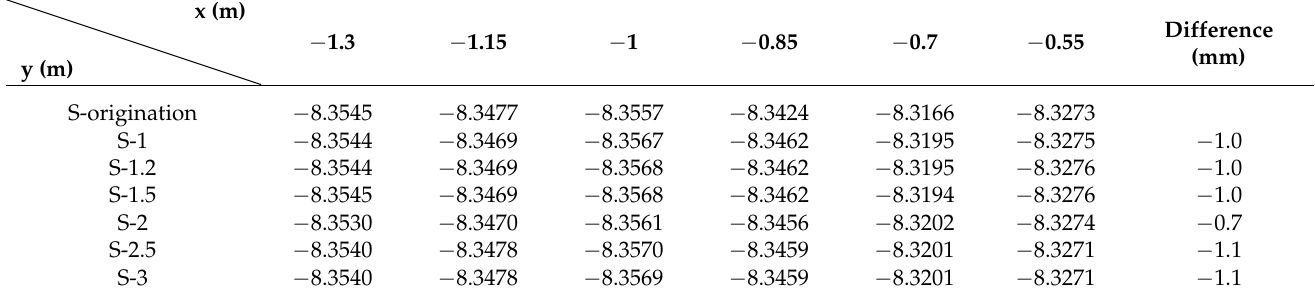
Figure 8. The fitted curves of the cross-section of S-LS: ( a ) The fitted curve of S-origination; ( b ) The fitted curve of S-2. In Figure 4, points on the x -axis are selected at equal intervals and the y values of fitted curves are calculated as shown in Table 9. The results indicate that the average difference in data with various densities is small. It can be observed that with the increase in density, the average difference decreases first, and then it increases. The minimum difference is achieved for S-2. Table 9. Comparison of data points of the S-LS.